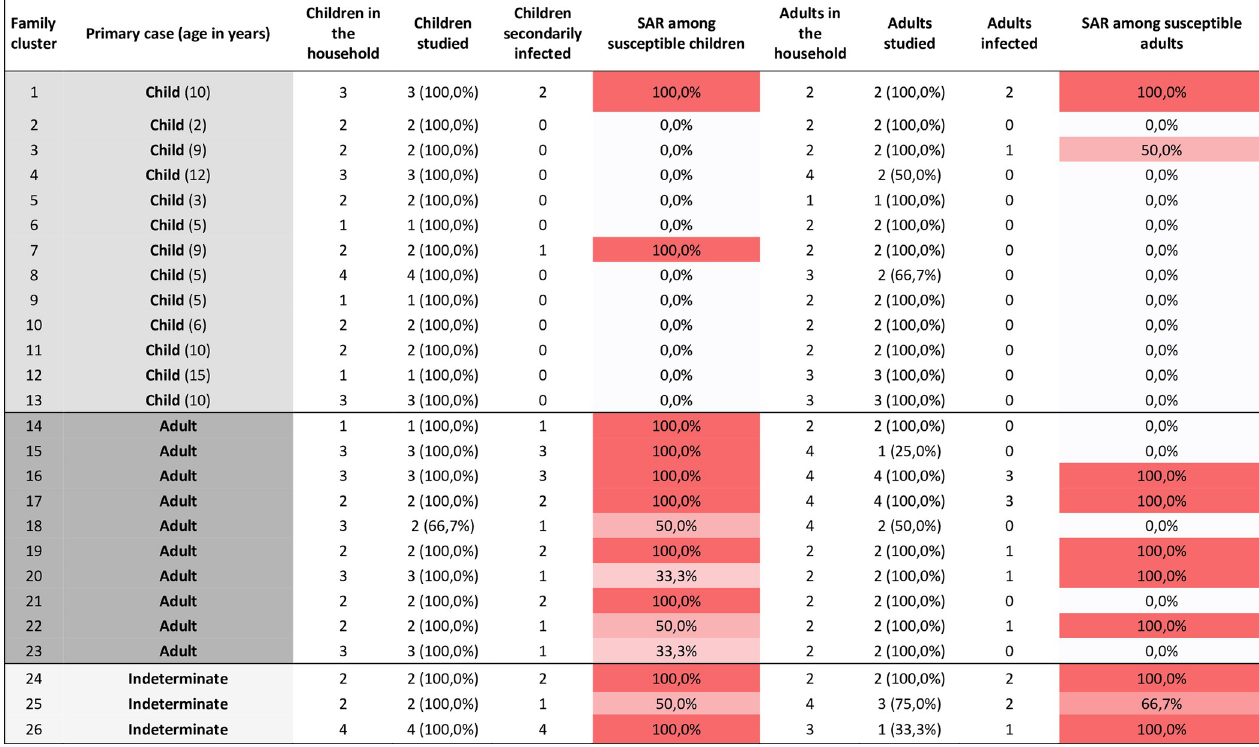
Fig 1. Number of inhabitants and SAR in each household according to the age-range of the primary case.